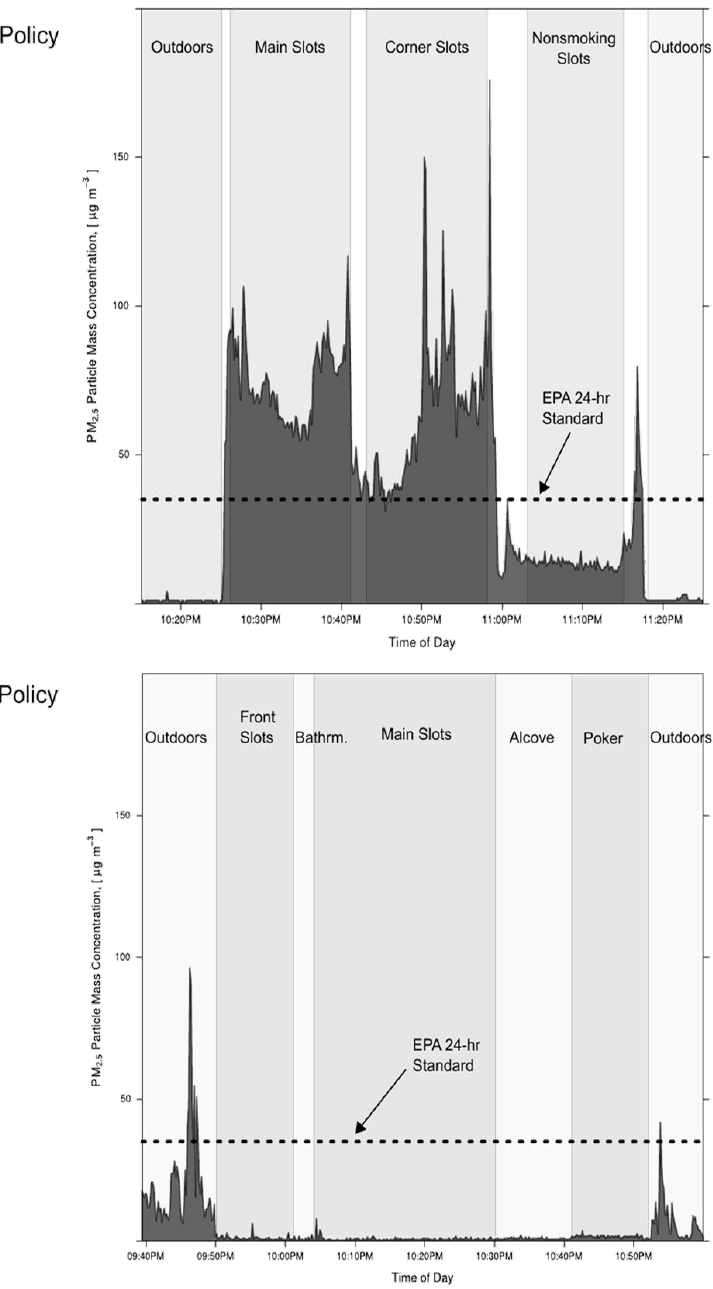
Figure 4. Plots illustrating the change in real-time 10-s fine particle (personal exposure) concentrations (PM 2.5 ) from before to after the adoption of a 100% casino-wide, smoke-free policy as measured by CAC visitors acting as patrons (sitting at slot and table games). The reduction in indoor particle levels after the smoke-free policy went into effect is apparent, as well as the increase in outdoor levels: ( A ) a Friday night in 2011 before the casino-wide smoke-free policy was adopted; and ( B ) a Friday night in 2014 after the smoke-free policy was adopted. The U.S. EPA 24-h health-based-standard for fine particles of 35 µ g/m 3 is shown as a horizontal dotted line. Approximately 40–60 active smokers were observed inside the ~20,000 square-foot smoking-allowed (slots + tables) area of the casino during the monitoring period in 2011. No tobacco smokers were observed inside the casino during the 2014 monitoring period, although several active e-cigarettes were